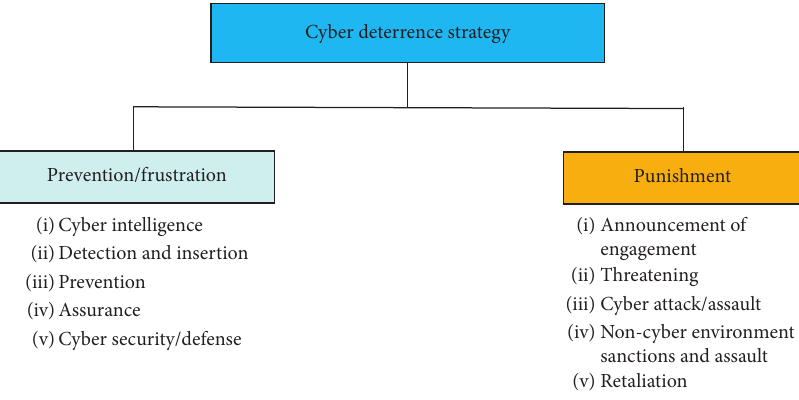
Figure 2: Cyber deterrence strategy methods and